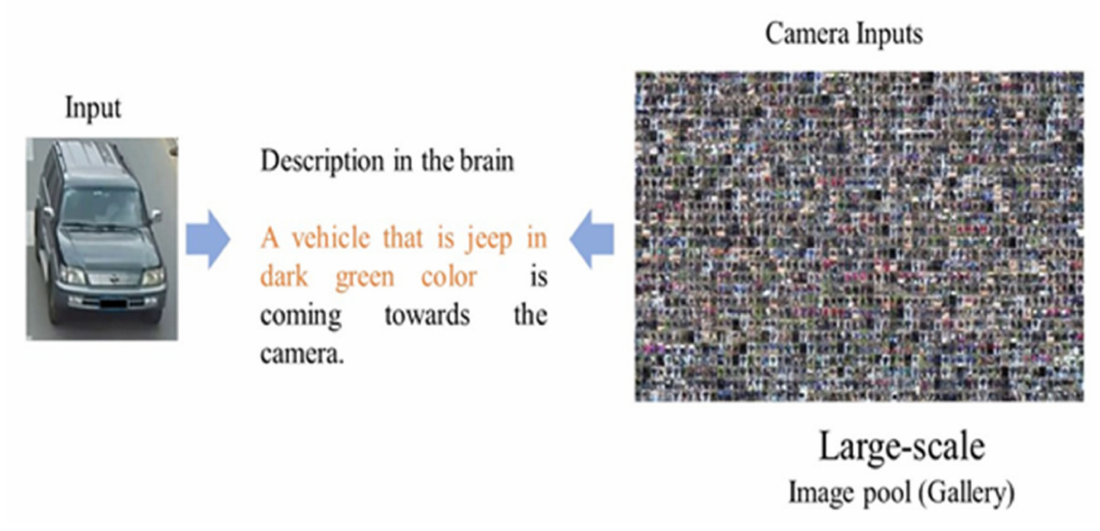
Figure 4. Shows how human re-identify vehicle?